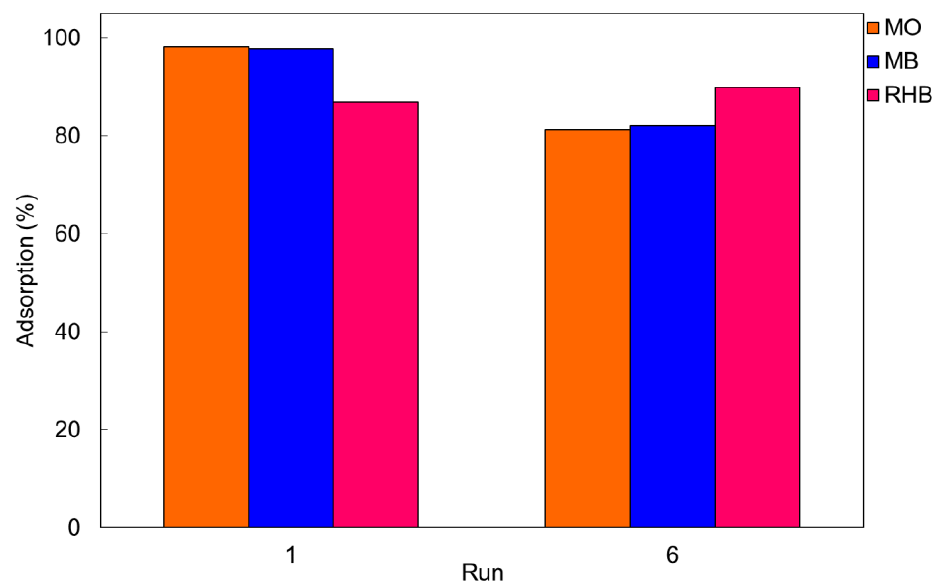
Figure 14. Comparison between the results of dyes adsorption using fresh materials (run 1) and after their regeneration (run 6).